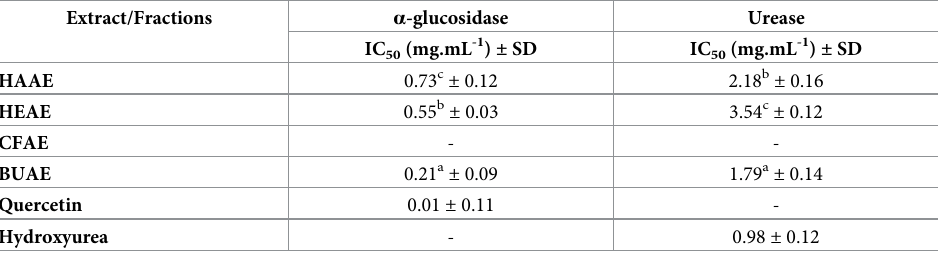
Table 3. α -glucosidase and urease inhibition assays of four solvent extracts of T . neotaliala .